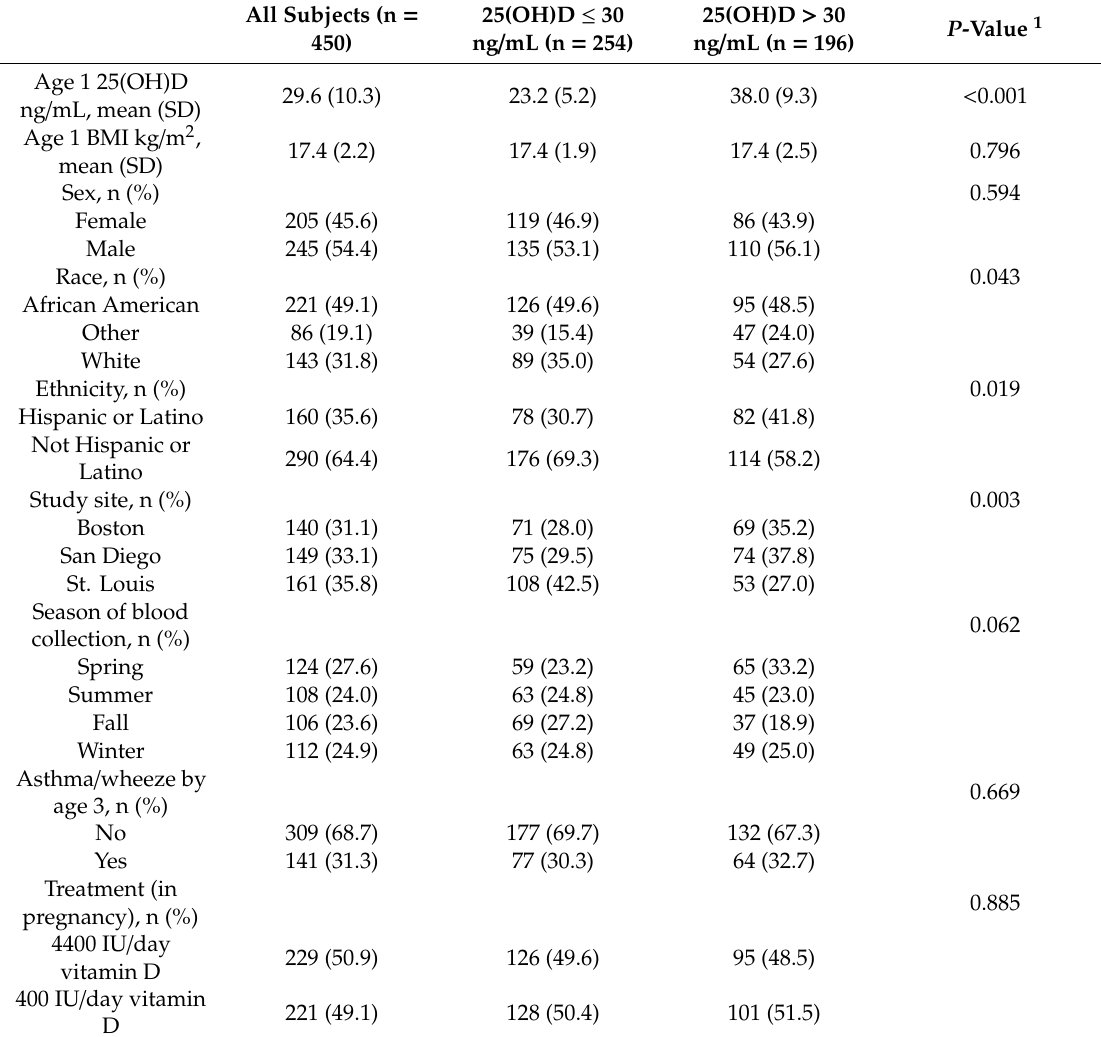
Table 1. Characteristics of VDAART children included in age 1